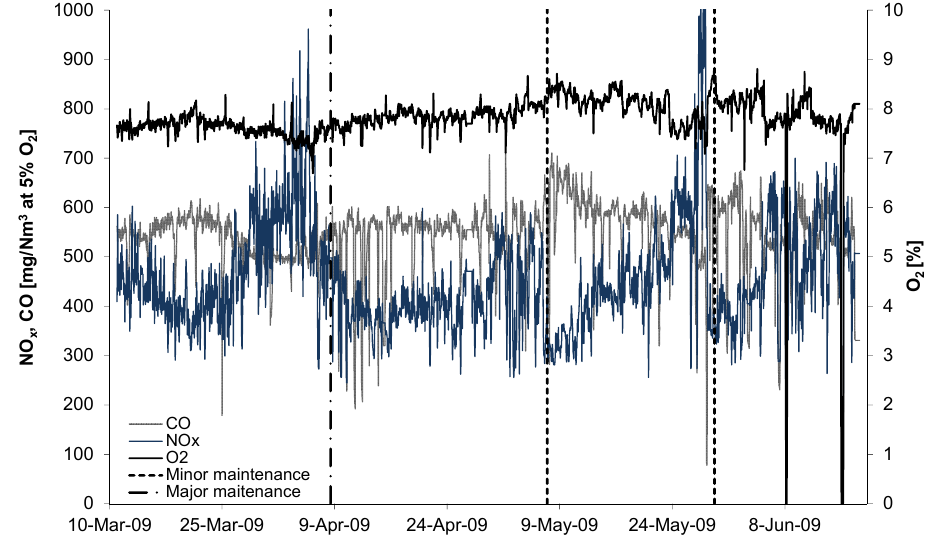
Figure 3. Recorded data for emissions from 10-Mar-09 to